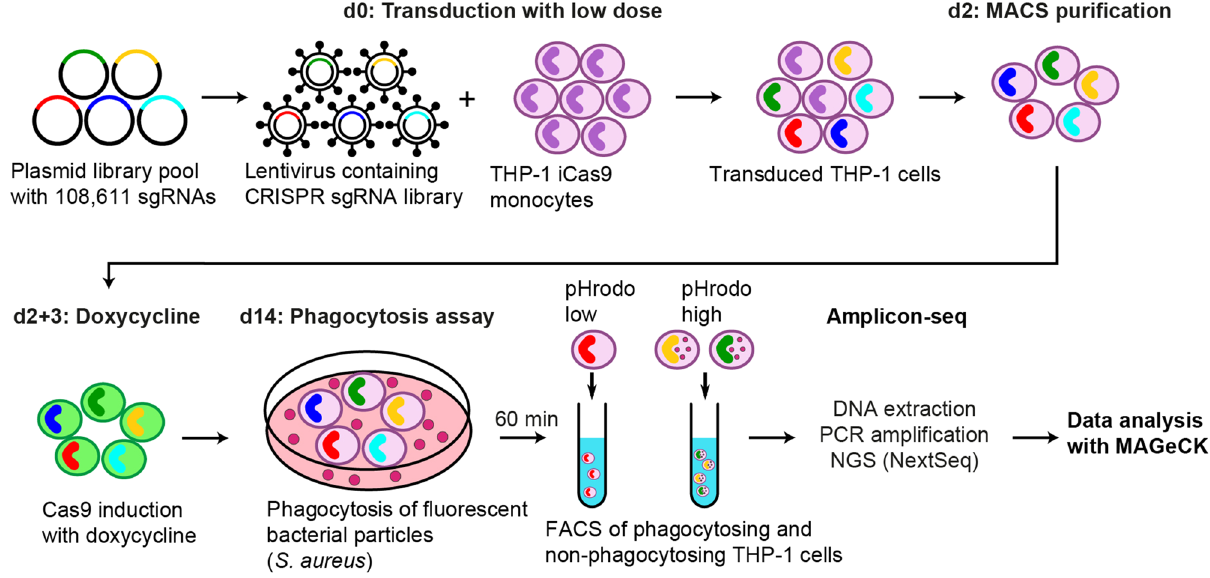
Figure 1. Genome-wide CRISPR screen for genetic regulators of phagocytosis of bacteria. THP-1 iCas9 cells were transduced at a coverage of 2919× with a genome-wide pooled sgRNA library containing 6 sgRNAs per gene and 500 non-targeting controls. Transduced cells were enriched by MACS and Cas9 was induced with dox on two consecutive days. 14 days after transduction, S. aureus particles labeled with pHrodo red was added to the cells. After 60 min, cells were sorted by FACS according to their fluorescence intensity in phagocytic active and inactive populations. The integrated sgRNAs were amplified and sequenced with NextSeq 550. Sequencing data was analyzed with